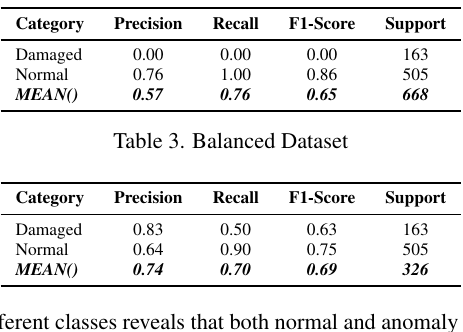
Figure 3. Figure 3a is image seen by input net after resizing of original image data. Figure 3b-3c are image rispectively up-down and left-right flipped from resized image. Figure 3d-3e-3f are image rotated rispectively of 90, 180 and 270 degree from resized image. either increasing the frequency of the minority class or decreas-